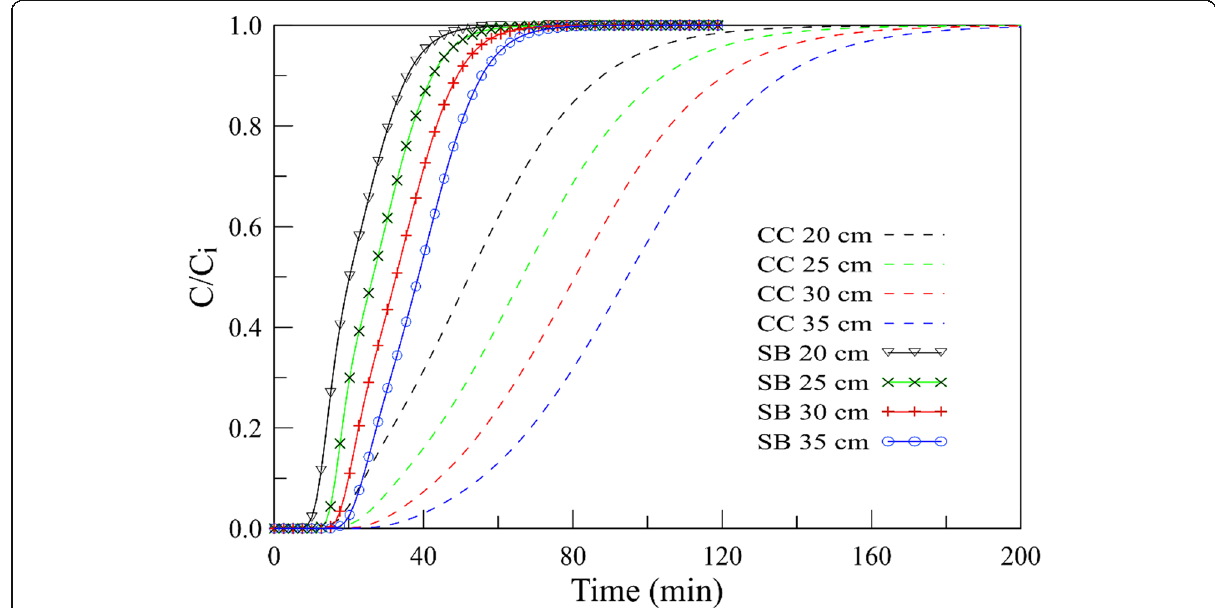
Fig. 5 Breakthrough curves of ACT adsorption on SB and CC by varying the bed